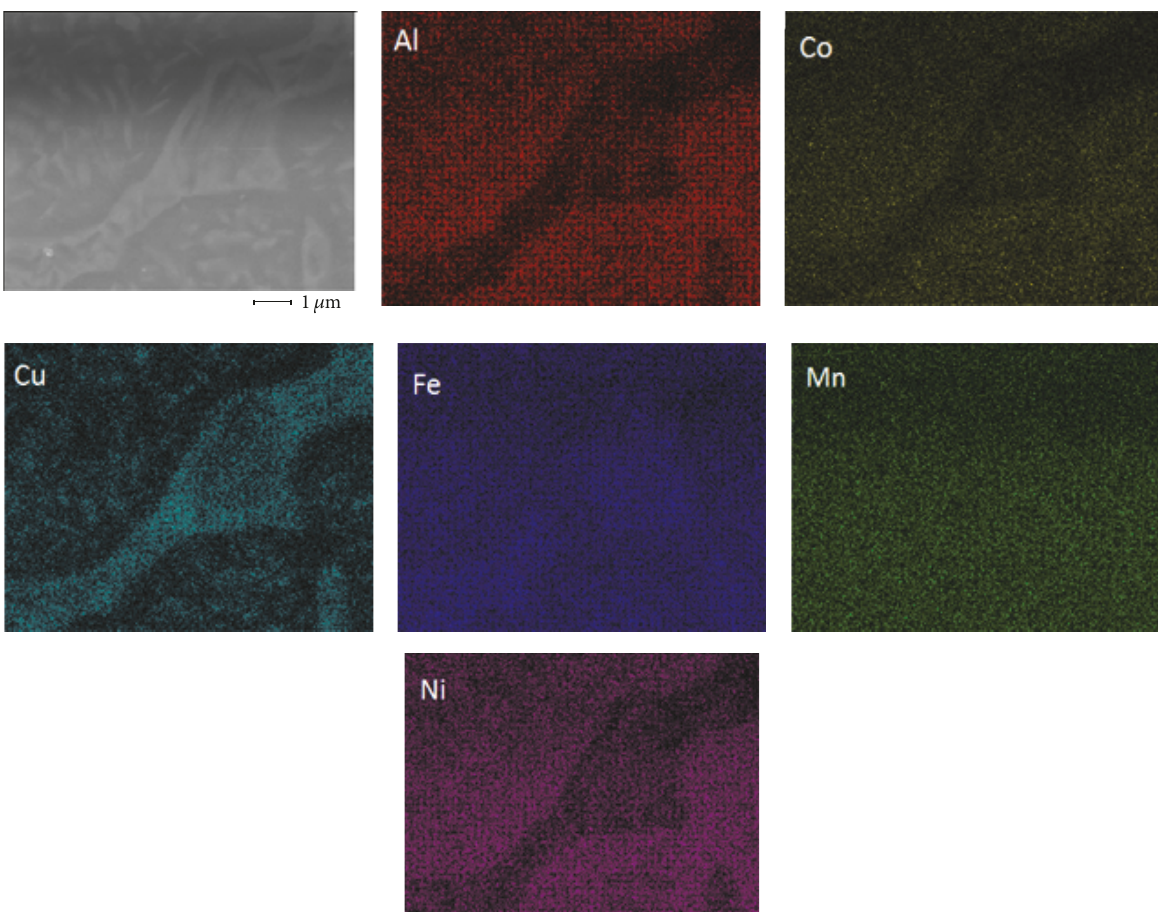
Figure 4: Elemental mapping of the heat-treated high entropy